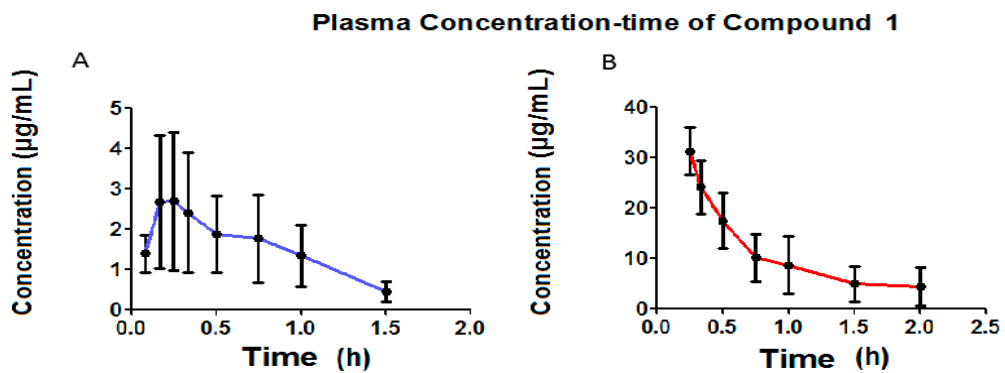
Figure 7. The Compound 1 plasma concentration ( μ g·mL − 1 ) time profile obtained oral administration